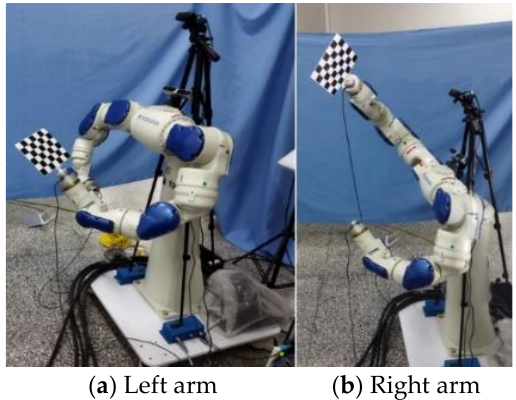
Figure 7. Calibration of the dual-arm hand – eye robot system.